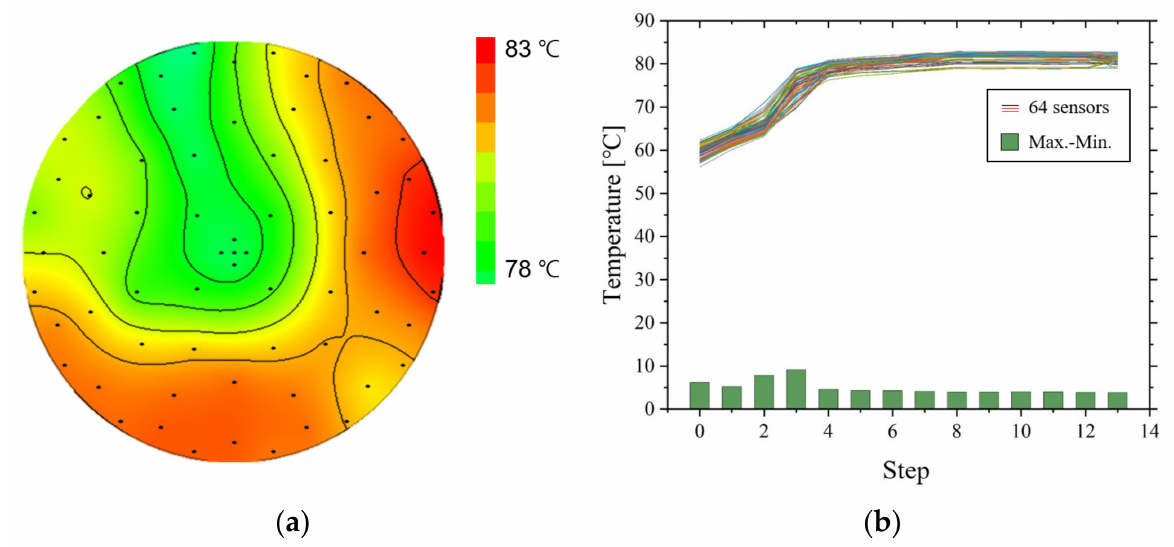
Figure 10. After repair ESC temperature distribution measurement distribution diagram: ( a ) heat map and contour map and ( b ) temperature measurement